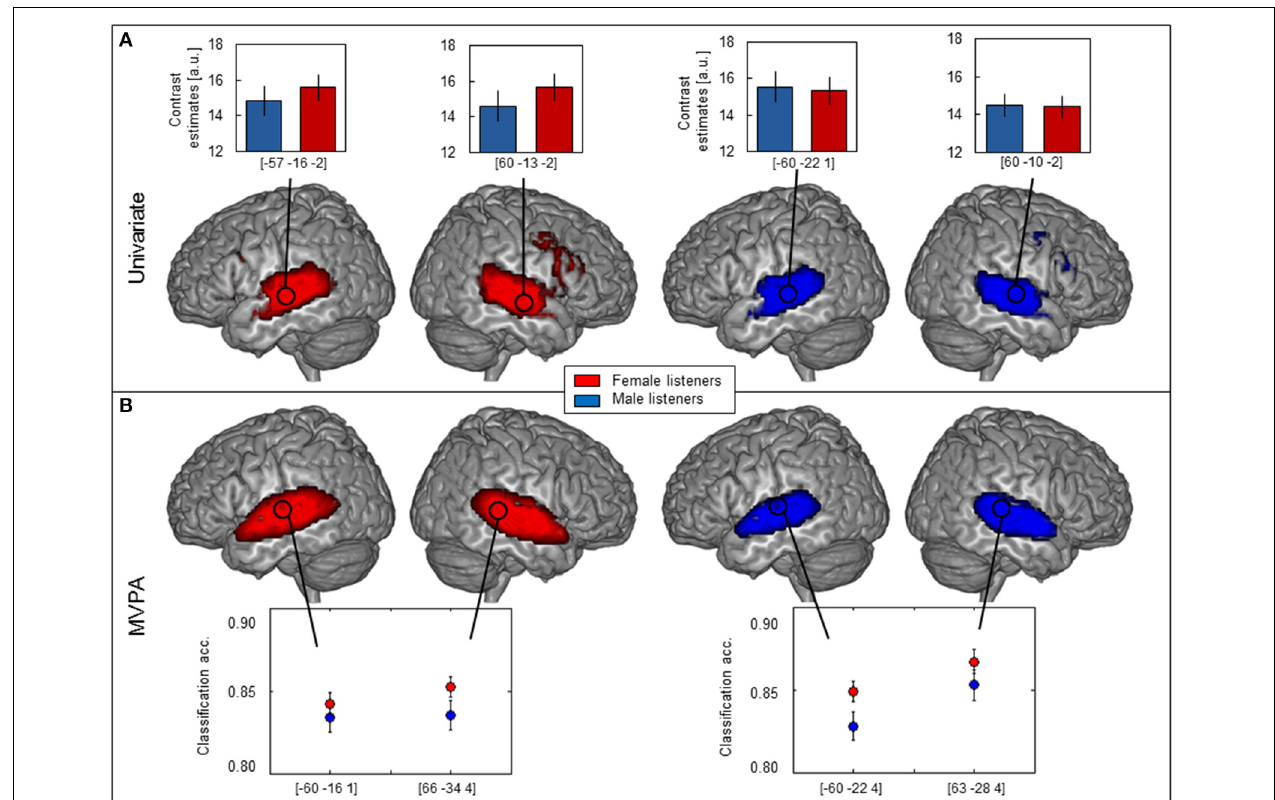
FIGURE 1 | Brain maps of female (red, n = 149) and male (blue, n = 123) participants. (A) Univariate analysis showing bilateral activation along the superior temporal sulcus (STS) and in the inferior frontal gyrus (IFG) and corresponding contrast estimates of vocal vs. non-vocal sounds plotted for peak voxel (one-sample t -test, FWE-corrected, p < 0 . 05; cf. circles, note that the two peaks with highest T -value and largest cluster size are indicated per